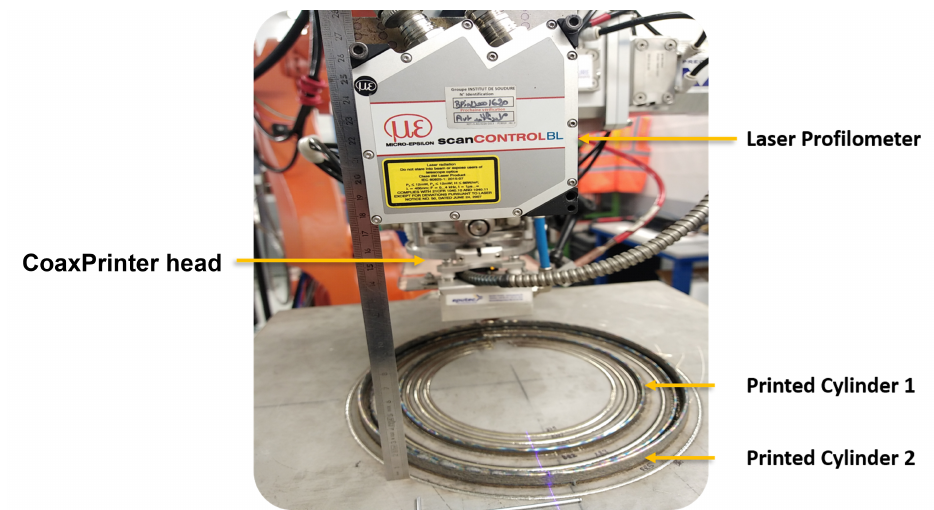
Figure 7. Profilometer set-up for data